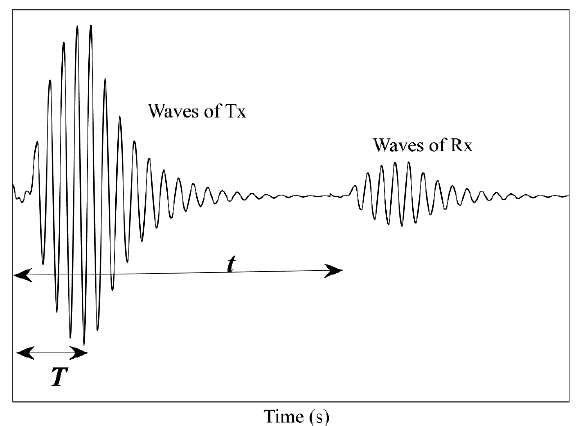
Figure 5. Transmitting and receiving waveforms.